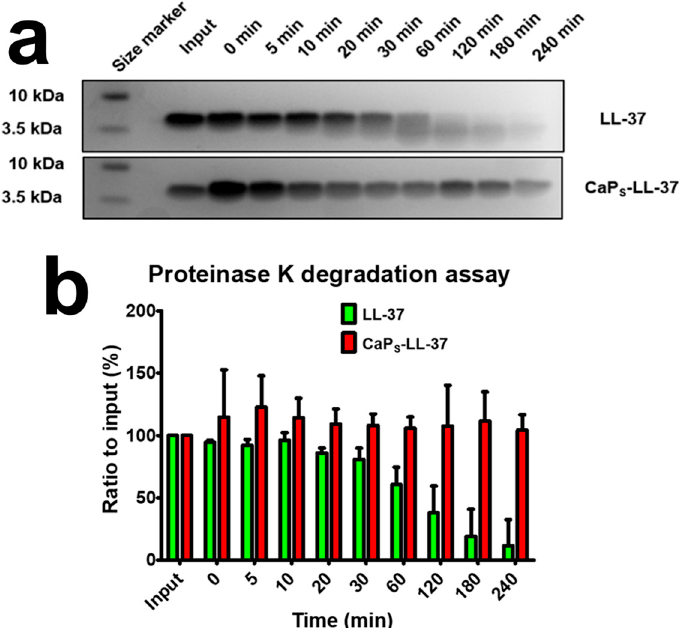
Figure 6. Proteinase K degradation assay of LL-37 in 20 mM Tris-HCl, pH 8.0 with a total of 20 ng Proteinase K. ( a ) Representative Sodium Dodecyl Sulfate–Polyacrylamide Gel Electrophoresis (SDS-PAGE) gels before and after proteolytic degradation of pure LL-37 and LL-37-loaded on CaP S nanoparticles. A clear LL-37 band can be seen at a size of 4.5 kDa which starts degrading steadily after 20 min incubation, however, when loaded on CaP S , the LL-37 resists degradation up until 240 min incubation. Input is the pure LL-37 or LL-37-loaded on CaP S nanoparticles (CaP S -LL-37) without any proteinase K added. Gel pictures shown are representative of at least three repetitions; ( b ) Quantification of bands for numerical assessment of degradation. Error bars are shown as standard deviation (N = 3).